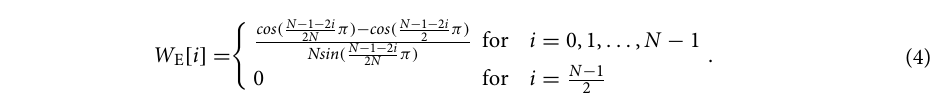
where n = ( N − 1 )/ 2, . . . , M − 1 − ( N − 1 )/ 2 , and W N [ l ] ( l = − ( N − 1 )/ 2, . . . , ( N − 1 )/ 2 ) is a moving window of odd length N . According to studies 2,8 , the length N is set to 44101.